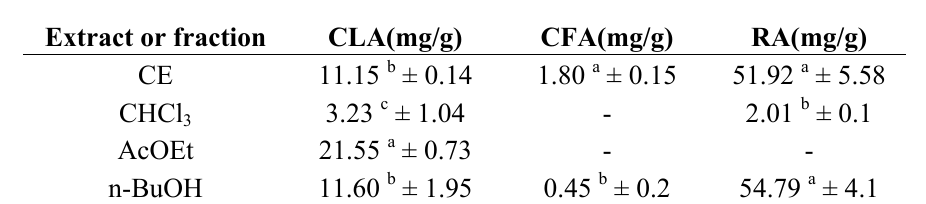
Table 3. Quantification of polyphenols in CE and fractions of S. guaraniticum by